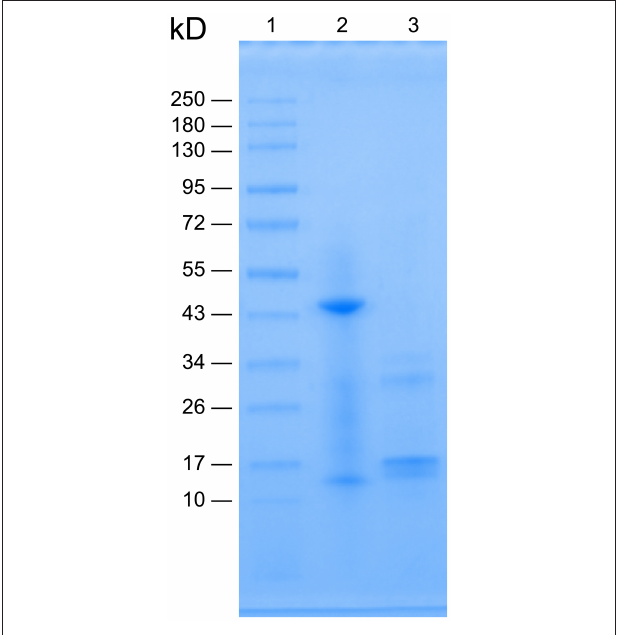
FIGURE 1 | SDS-PAGE image of Perinereis aibuhitensis hemoglobin. Line 1: molecular weight standards; Line 2: non-reduced Hb without β -mercaptoethanol treatment and heating at 97 ◦ C for 5min; Line 3: reduced Hb treated with β -mercaptoethanol and heating at 97 ◦ C for